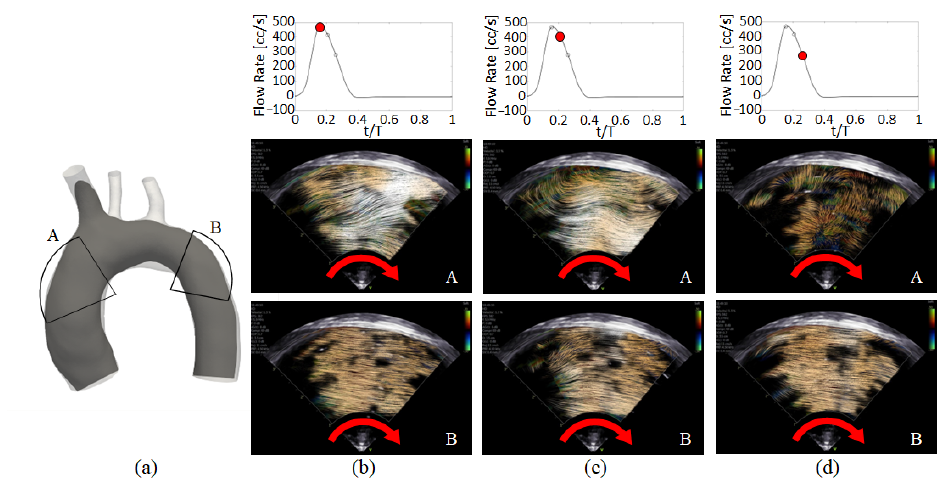
Figure 6. ( a ) Sketch of the healthy aorta geometry (light gray) and of its sagittal plane (dark gray). Echographic results at ( b ) t / T = 0.156, ( c ) t / T = 0.208, and ( d ) t / T = 0.260.